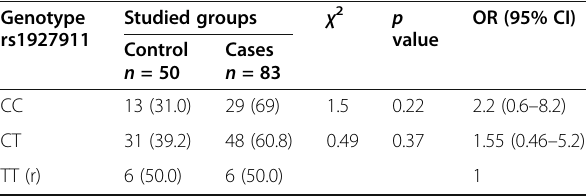
Table 11 rs11536858 and rs1927914 allele combination distribution between cases and control